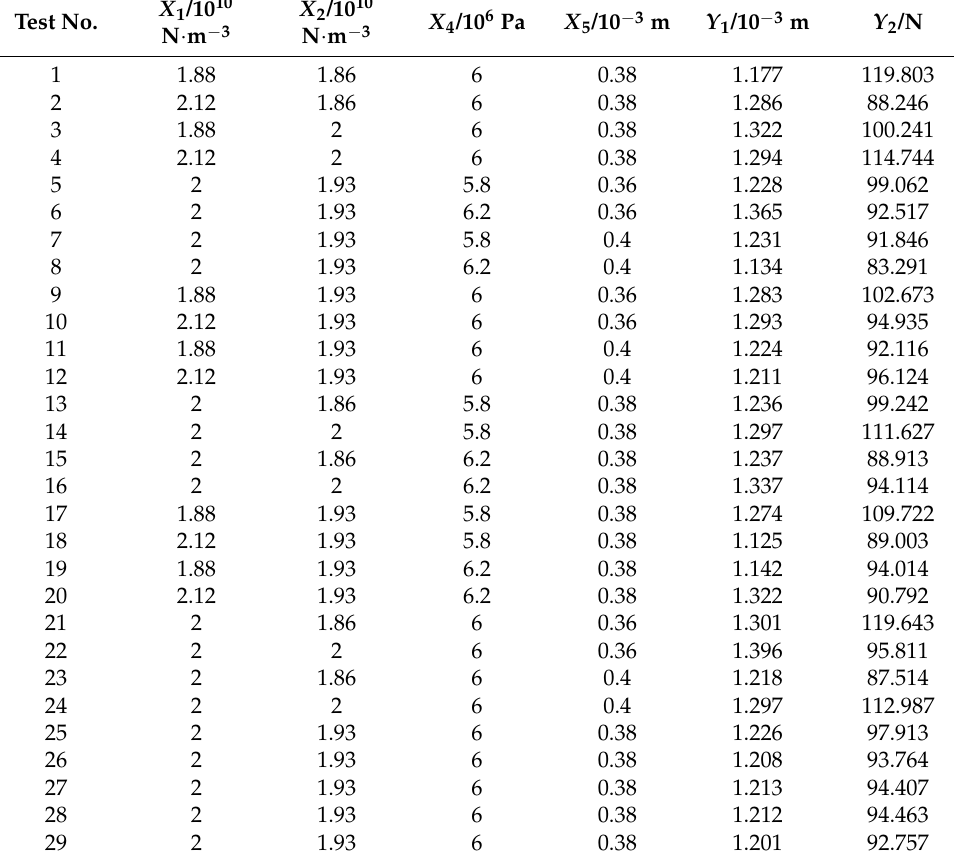
Table 10. Results of the Box–Behnken test. Test